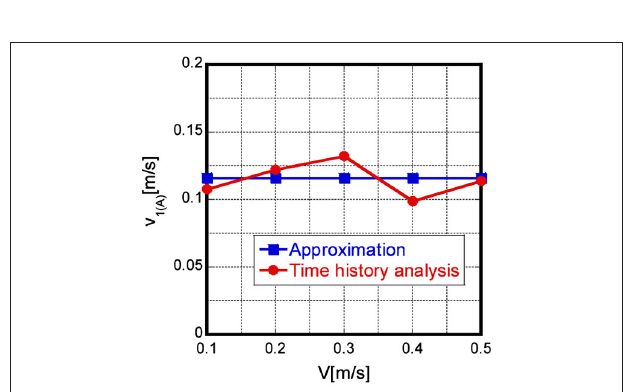
FIGURE 5 | Restoring force-interstory drift relation in first story under critical multi impulse.